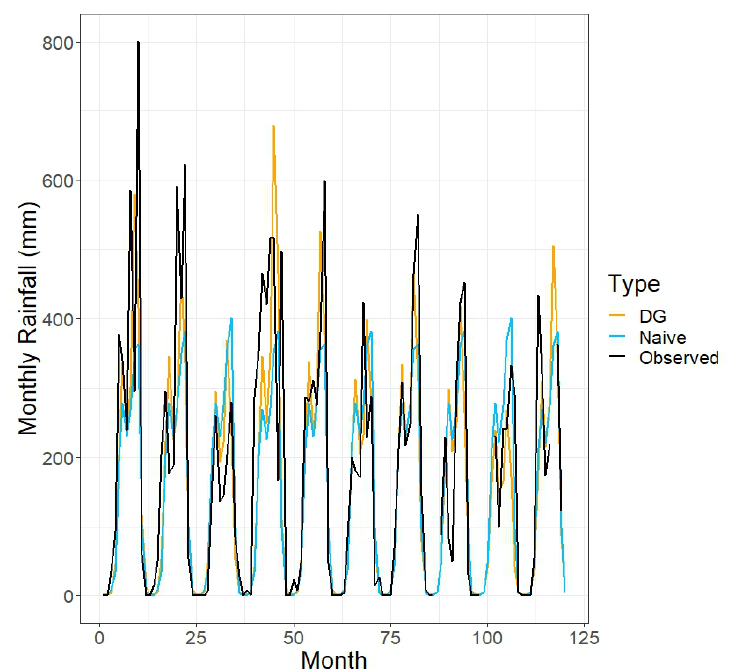
Figure 7. One-month-ahead predicted (using the double Gaussian and naive approaches) and observed monthly rainfall values at the Nicoya station from 2007 to 2016. “Month” is the number of months since January 2007.